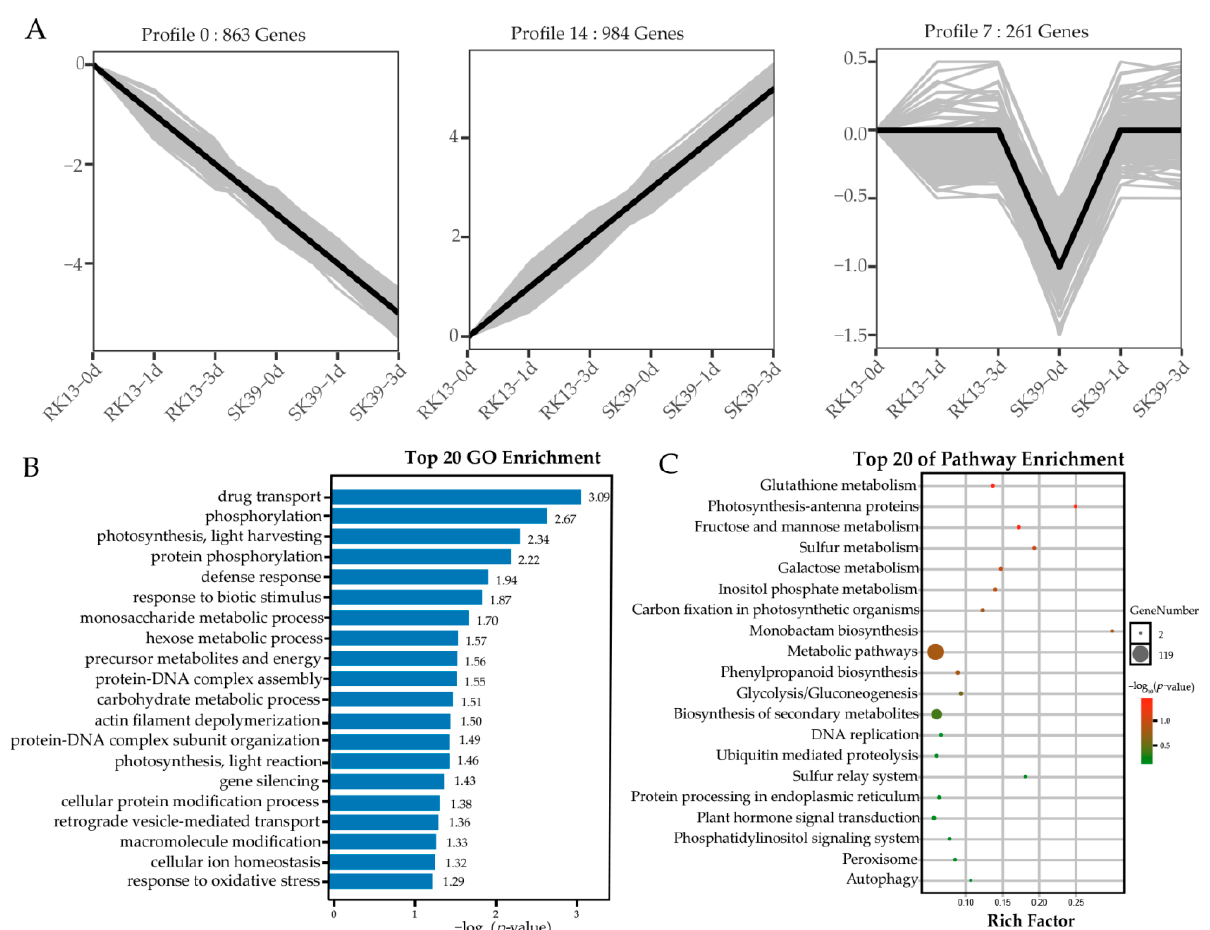
Figure 4. Clustering analysis of co-expressed DEGs in the three groups (RK13, SK39 and SK39_vs_RK13). ( A ) Gene expression patterns across time points. Significant trends ( p < 0.05) were presented. The gray and black lines represent each gene’s expression pattern and the expression trend of all genes, respectively. ( B ) GO enrichment analysis of co-expressed DEGs. Blue bars represent the significance of terms ( p -value). ( C ) The KEGG pathway enrichment of co-expressed DEGs. The size of the circle represents the number of genes enriched. The color of the circle represents the significance of the pathway; the darker the red the more significant, while green means low significance.